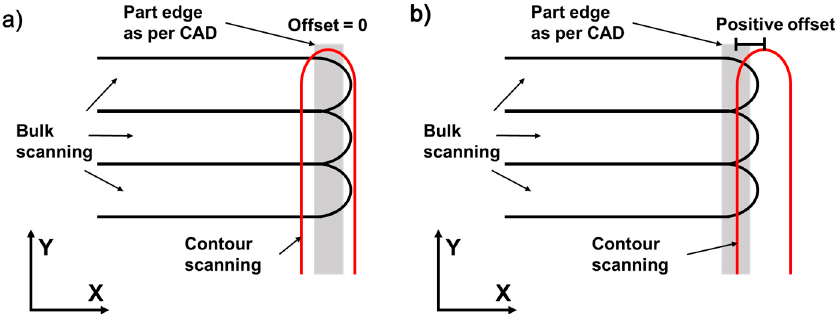
Figure 3. Schematic of bulk scanning vs. contour scanning on a sample. ( a ) Contour scanning without offset (default settings). ( b ) Contour scanning with a positive offset.